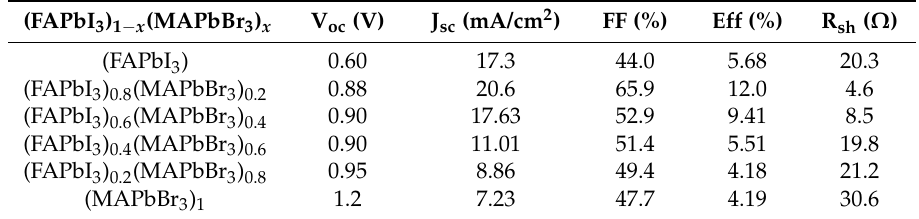
Figure 5. J-V curves of perovskite solar cell (Ag/BCP/C 60 /(FAPbI 3 ) 1− x (MAPbBr 3 ) x /PEDOT:PSS/ITO) obtained under standard 1 sun air mass (AM) 1.5 simulated solar irradiation. Table 1. Parameters of solar cells based on perovskite (FAPbI 3 ) 1− x (MAPbBr 3 ) x film with various composition ratios.